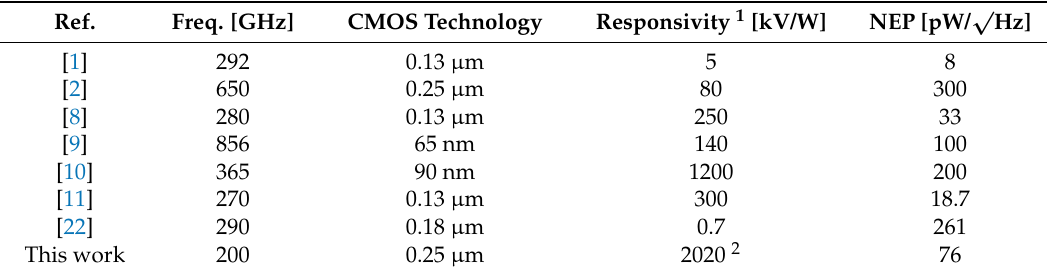
Figure 9. Effective signal-to-noise ratio (SNR) at the output of the proposed detector using the 103 Hz chopping frequency and spectrum analyzer. Table 2. Comparisons of the sub-THz detectors.